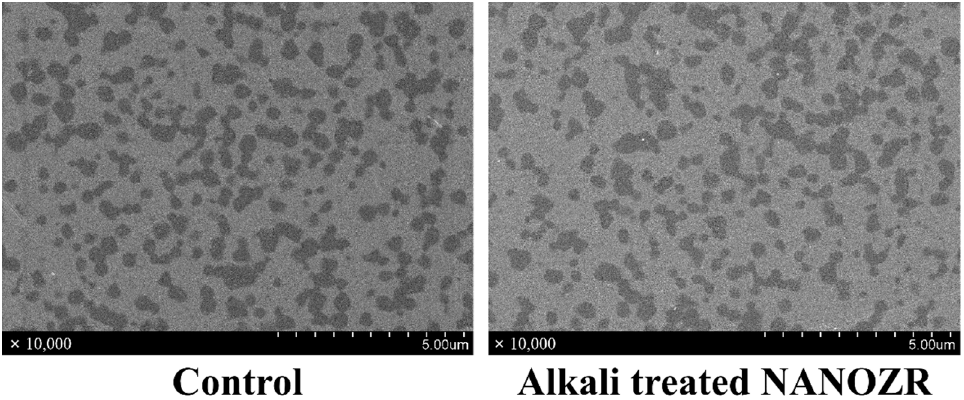
Figure 1. SEM micrographs of control and test groups.